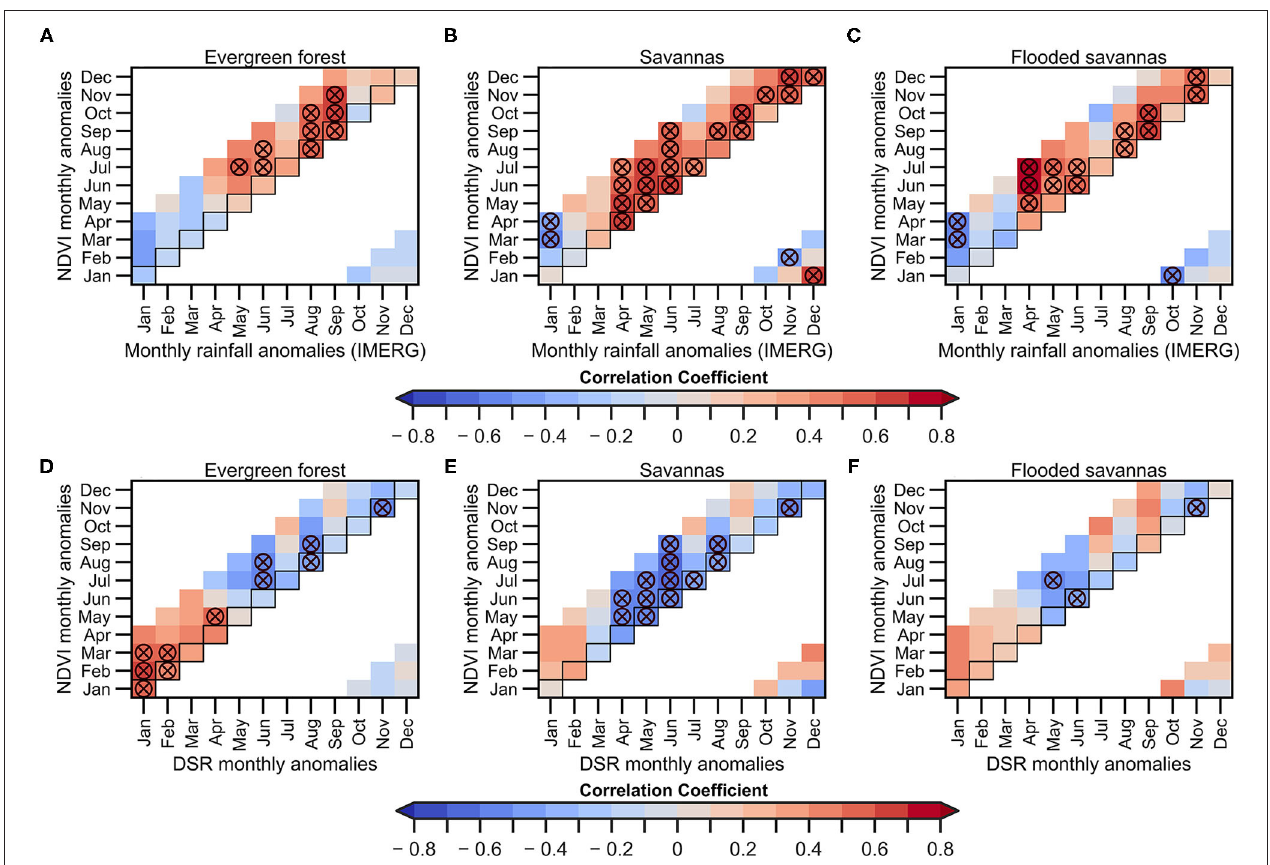
FIGURE 5 | 2000–2019 monthly lagged correlations between NDVI anomalies for the three predominant land cover types over the upper Madeira Basin and: precipitation anomalies (A–C) and DSR (D–F) . For evergreen forests (A,D) , savannas (B,E) , and flooded savannas (C,F) . Precipitation anomalies are estimated using GPM-IMERG data. NDVI anomalies of the predominant land cover types are calculated below the 1,000m.a.s.l. The horizontal axis indicates the month correspondent to the average precipitation and DSR anomalies, while the vertical axis indicates the lag of response of the NDVI. Circles marked with the X symbol indicate significant correlations ( p < 0.05). Not computed correlation coefficients are shown in white